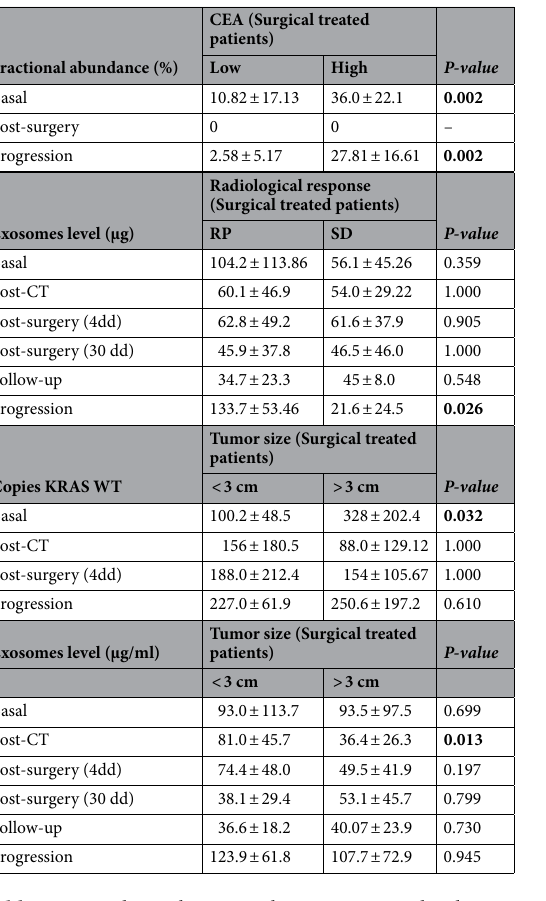
Table 2. Correlation between plasma exosomes level, KRAS copies and clinical-pathological characteristics in metastatic patients undergoing surgery.